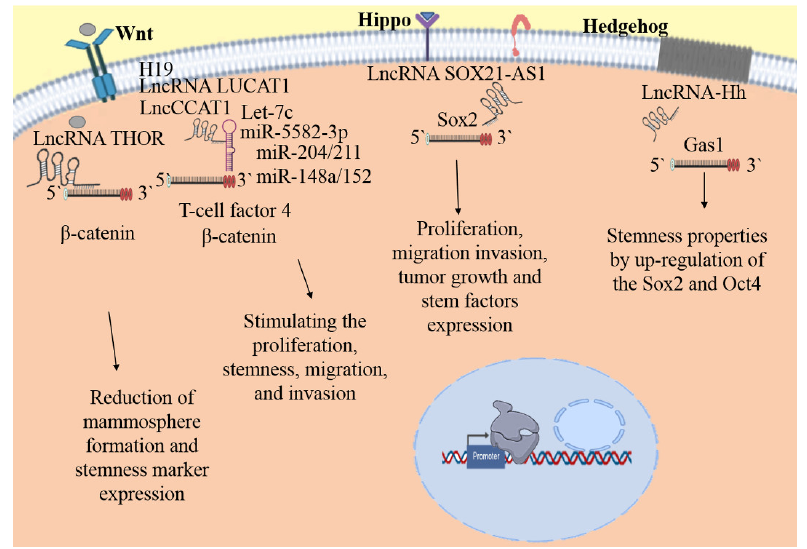
Figure 2. Signaling pathways modulate by lncRNAs in bCSC. The lncRNAs playing transcendent roles in the bCSC biology acting as sponges of miRNAs, the lncRNAs influence the expression levels of the targets of miRNA, or by direct bind to mRNA, impacting in the proliferation, maintenance, self-renewal, migration, and invasion of bCSC. Until now, the information about the lncRNA and the signaling pathways is scarce. Wnt, Hippo, and Hh are the main explored pathways related with lncRNAs regulation in bCSC. Some targets modulated by miRNAs: Wnt, β- catenin, T-cell factor 4; Hippo, Sox2 and Hh, Gas1.